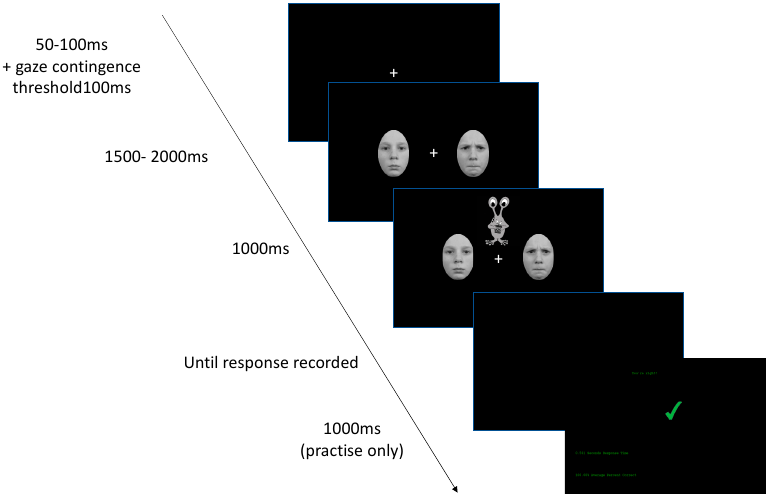
Figure 2. Schematic representation of practice and experimental Figure 2 . Schematic representation of practice and experimental trials.